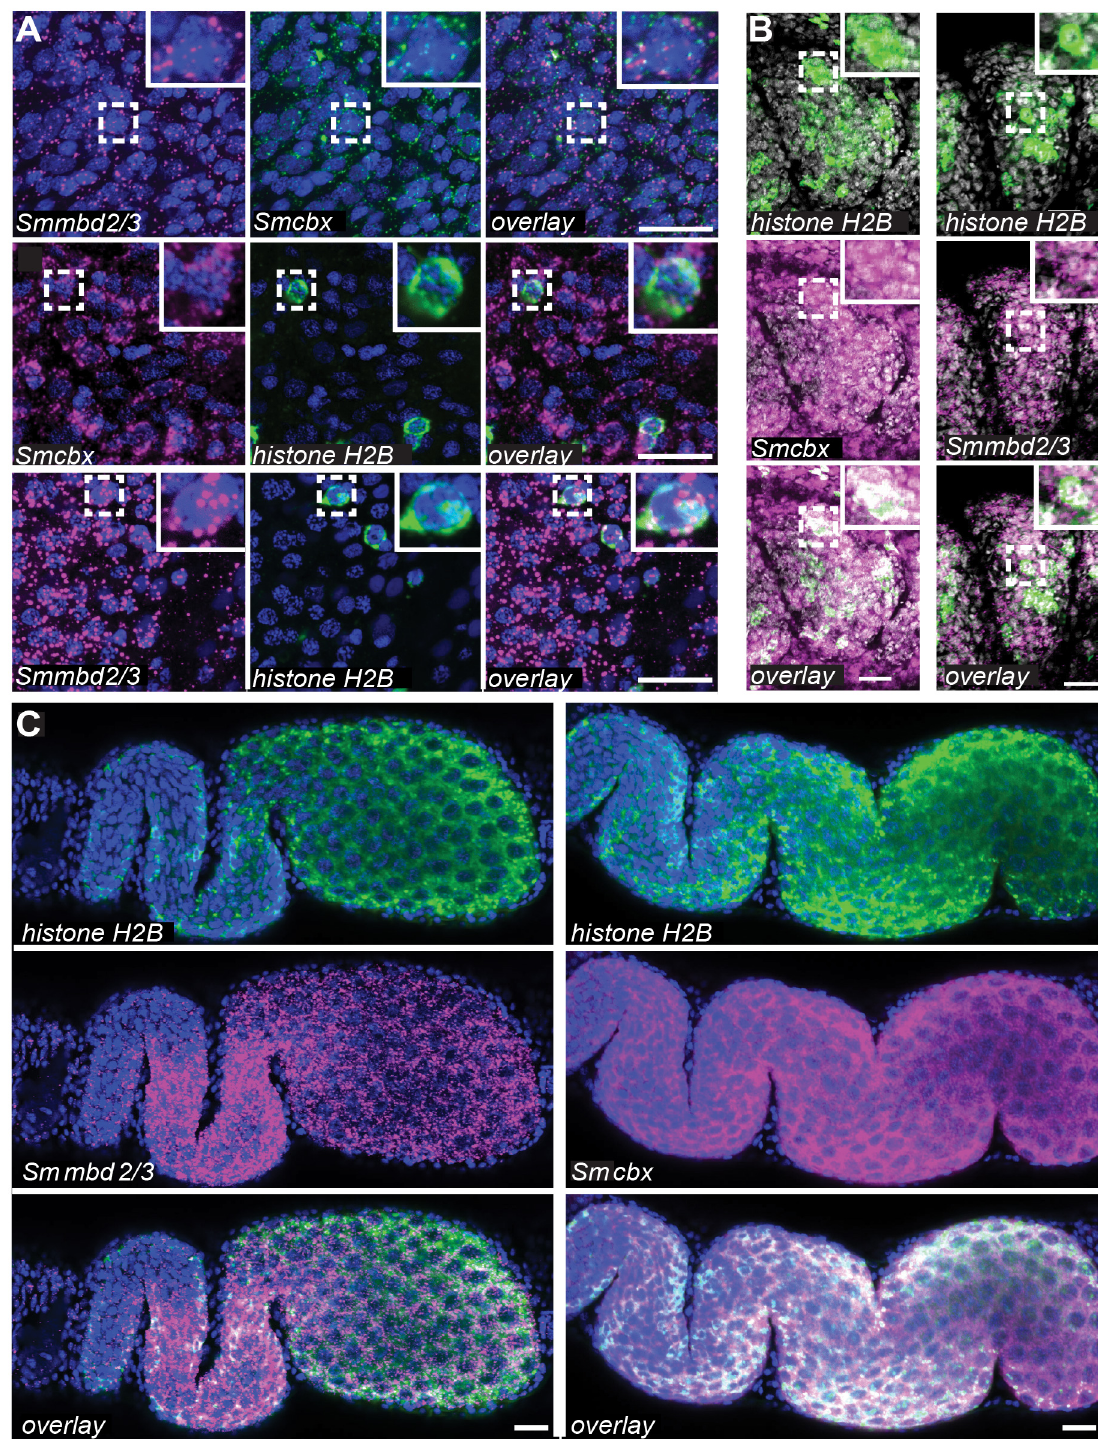
Fig 5. Smmbd2/3 and Smcbx are broadly expressed in male and female schistosomes. (A) Expression of Smmbd2/3 and Smcbx in male somatic tissues, (B) testes and (C) ovaries relative to Smhistone H2B .Both genes are broadly expressed in somatic tissues, including the histone H2B + neoblasts and in most cell types ( histone H2B - ) within the male and female germ line. Scale bars = 20 μm. Blue = DAPI. Magenta and green = pseudocoloured antisense RNA probes for Smmbd2/3 , Smcbx and Smhistone H2B .White = co-localisation of two RNA probes. Where illustrated, delineated areas (dashed white boxes) are magnified in the insets (solid white boxes).